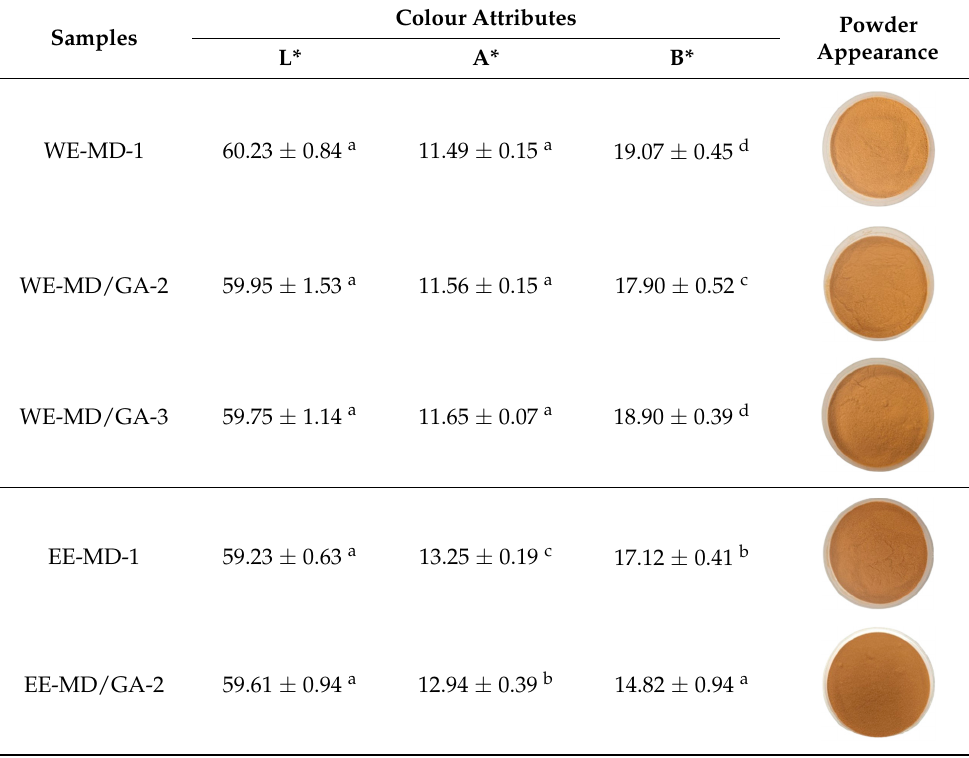
Table 3. Color attributes and appearance of spray-dried C. paliurus extracts.